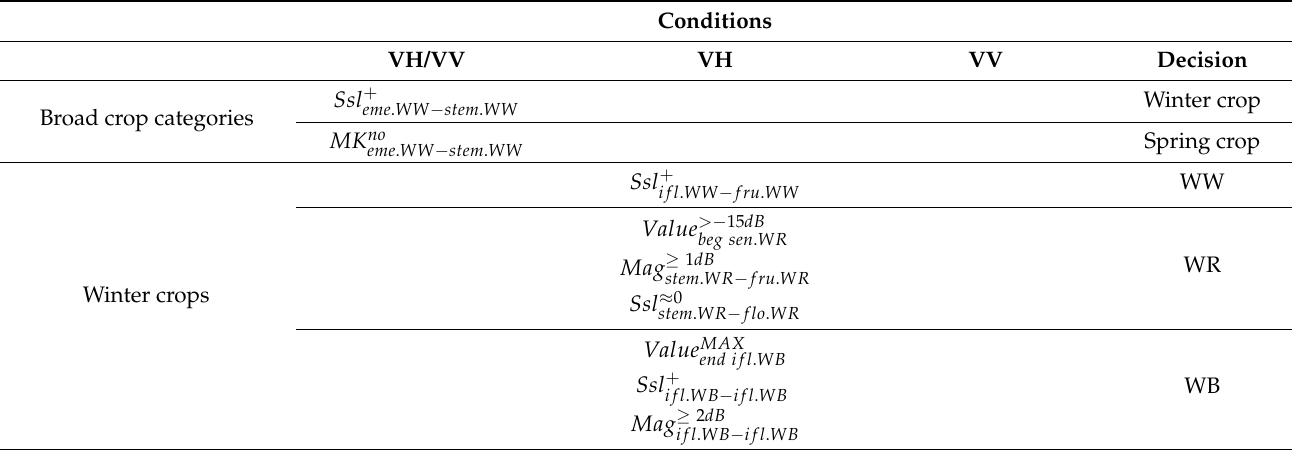
Table A1. Summary of the key SAR dynamics (mathematical measures) that are used in the decision algorithm. The key conditions are hierarchically organized as in the algorithm (i.e., starting with winter/spring crop distinction based on mathematical conditions applied to VH/VV ratio and finishing by the classification of spring wheat). The grassland category is assigned when none of the mathematical conditions are met. MK no indicates that no significant trend GS 1. X − GS 2. X (i.e., p -value > 0.01) is detected by the Mann–Kendall trend test between the beginning of GS1 (i.e., (knowledge-based) starting date of Growth Stage 1) and the end of GS2 of the crop X. Ssl + / − signifies a significant (i.e., p -value < 0.01) GS 1. X − GS 2. X positive/negative slope (using Sen’s slope statistical test) between the beginning of GS1 and the end of GS2 of the